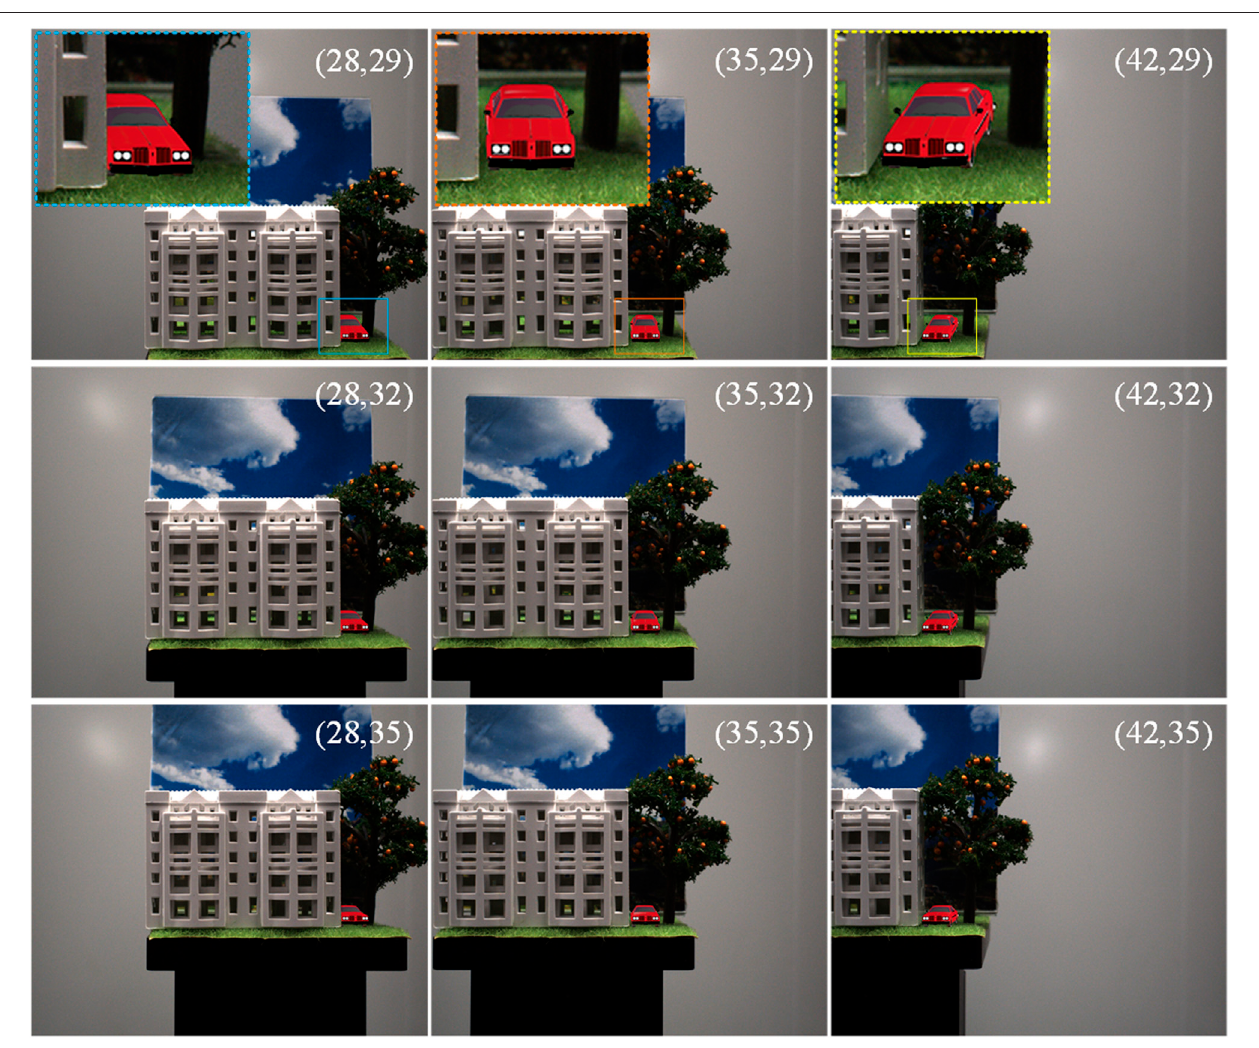
FIGURE 8 | Nine encoded